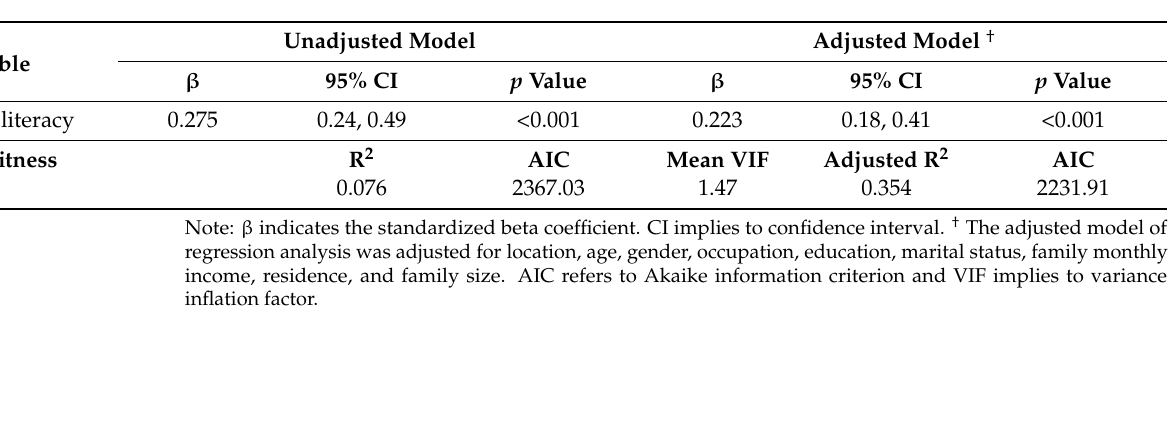
Table 3. Linear regression model for healthy eating behaviors explained by nutrition